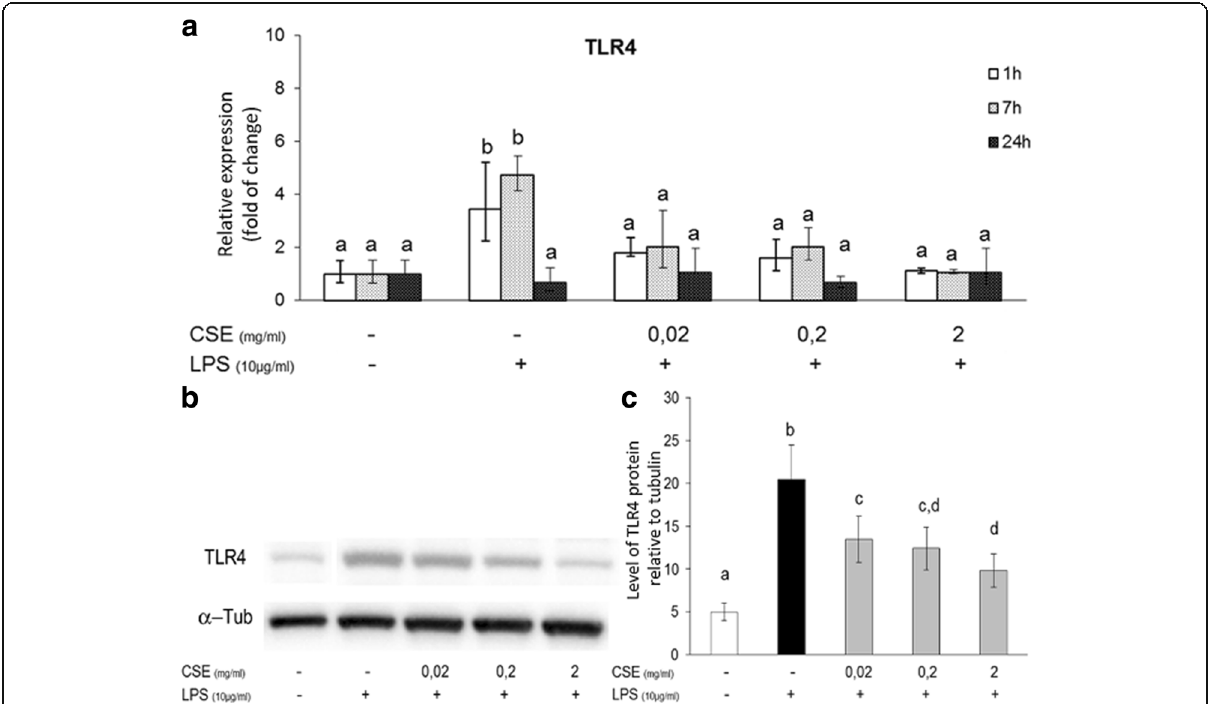
Fig. 2 Effect of Cucumis sativus L. extract (CSE) on LPS induced TLR4 expression. a Expression of TLR4 mRNA in pAECs treated with LPS (10 μ g/ml) for different time (1, 7, 24 h) in the presence or absence of increasing doses of CSE (0.02; 0.2; 2 mg/ml). mRNA expression of TLR4 is determined by quantitative PCR; relative expression was calculated as fold of change in respect to the control cells and error bar represents the range of relative expression. Different letters above the bars indicate significant differences. b Representative Western Blot of TLR4 and relative housekeeping α -tubulin were reported. c Expression of TLR4 protein in pAECs treated with LPS (10 μ g/ml) in the presence or absence of increasing doses CSE (0.02; 0.2; 2 mg/ ml); data shown are representative of at least three independent experiments and represent the mean±SEM. Different letters above the bars indicate significant differences ( p < 0.05 ANOVA post hoc Tukey ’ s